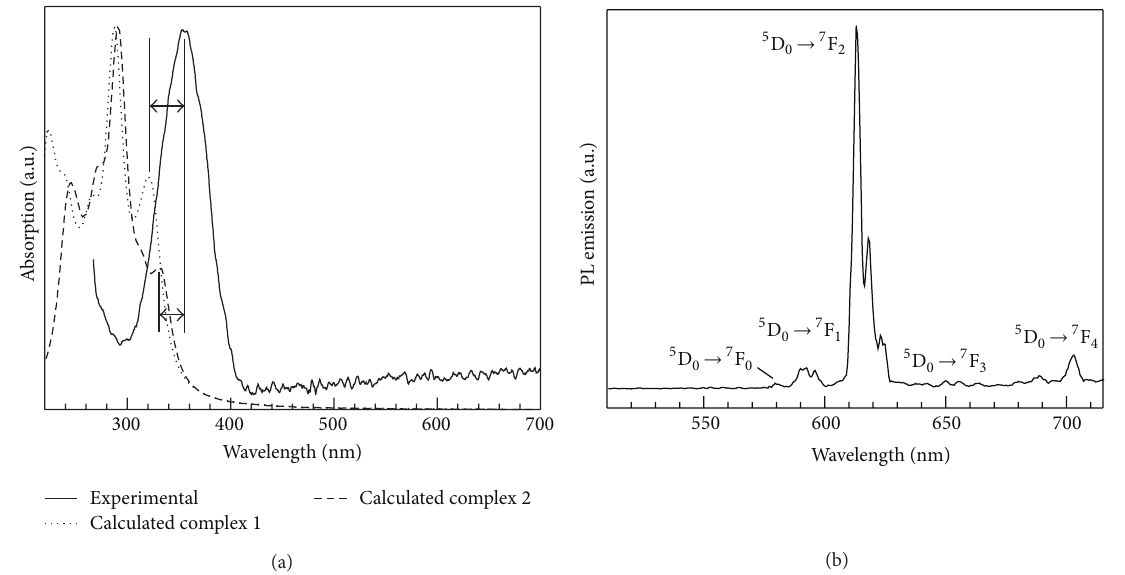
Figure 6: (a) UV-Vis absorption spectrum and (b) photoluminescent emission spectrum in powder form for the mixture of complex 1 and complex 2 upon ligand-mediated excitation in the UV ( 𝜆 = 355 nm).